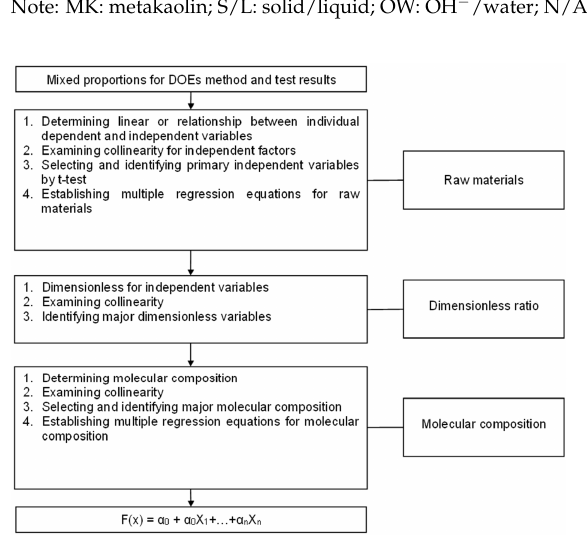
Figure 1. Flowchart of statistical analysis.